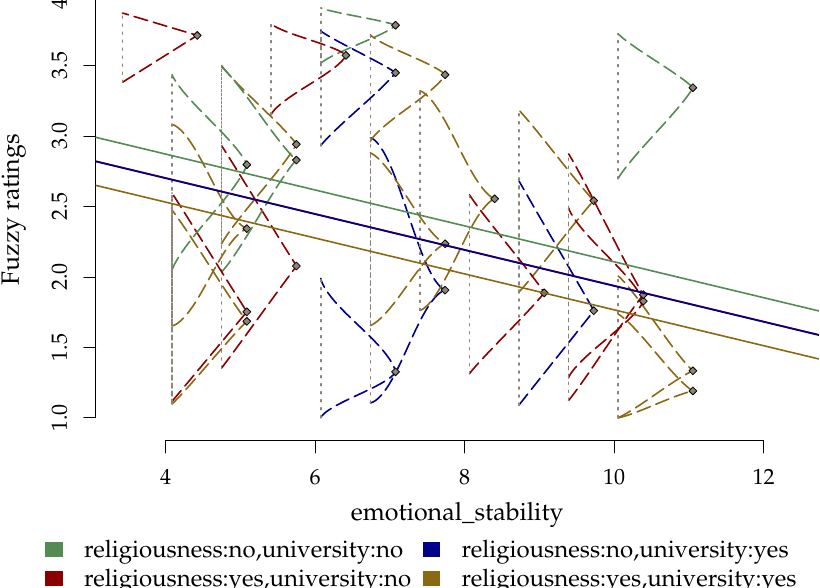
Figure 5. Application: Fitted regression lines against the observed fuzzy ratings as a function of both categorical and continuous predictors. Note that the four regression lines correspond to the four categorical levels of religiousness and university (the line associated with religiousness:yes university:no is overlapped with the line of religiousness:no